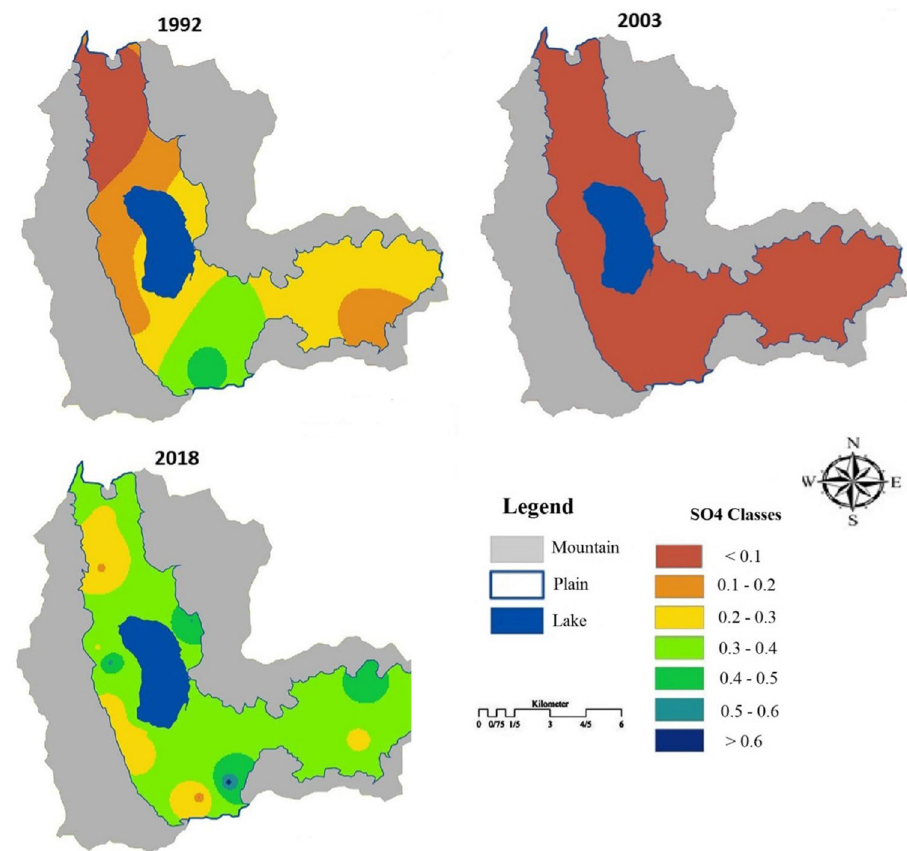
Fig. 7 Spatial variations